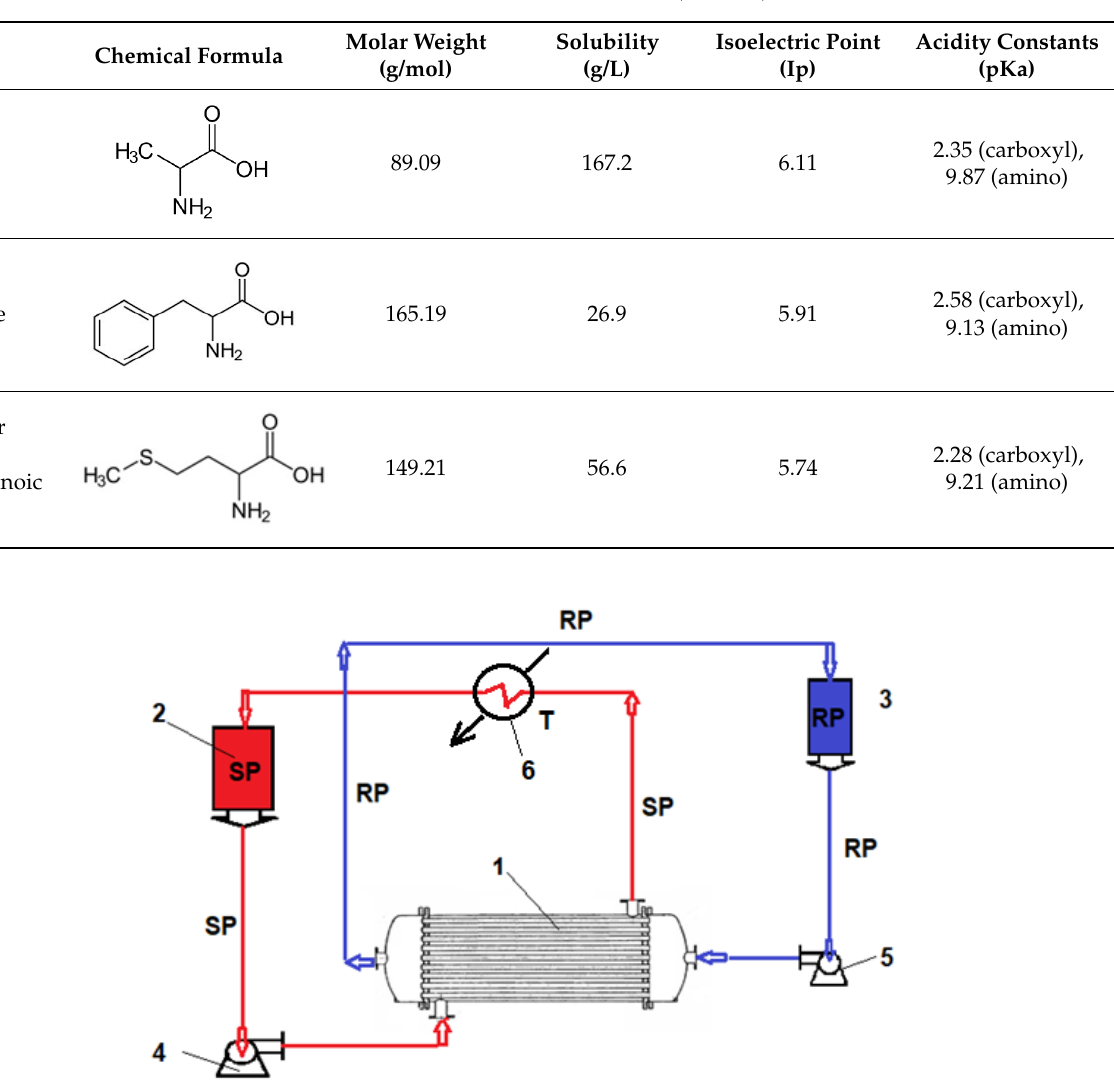
Table 3. The characteristics of the tested amino acids (at 25 °C).